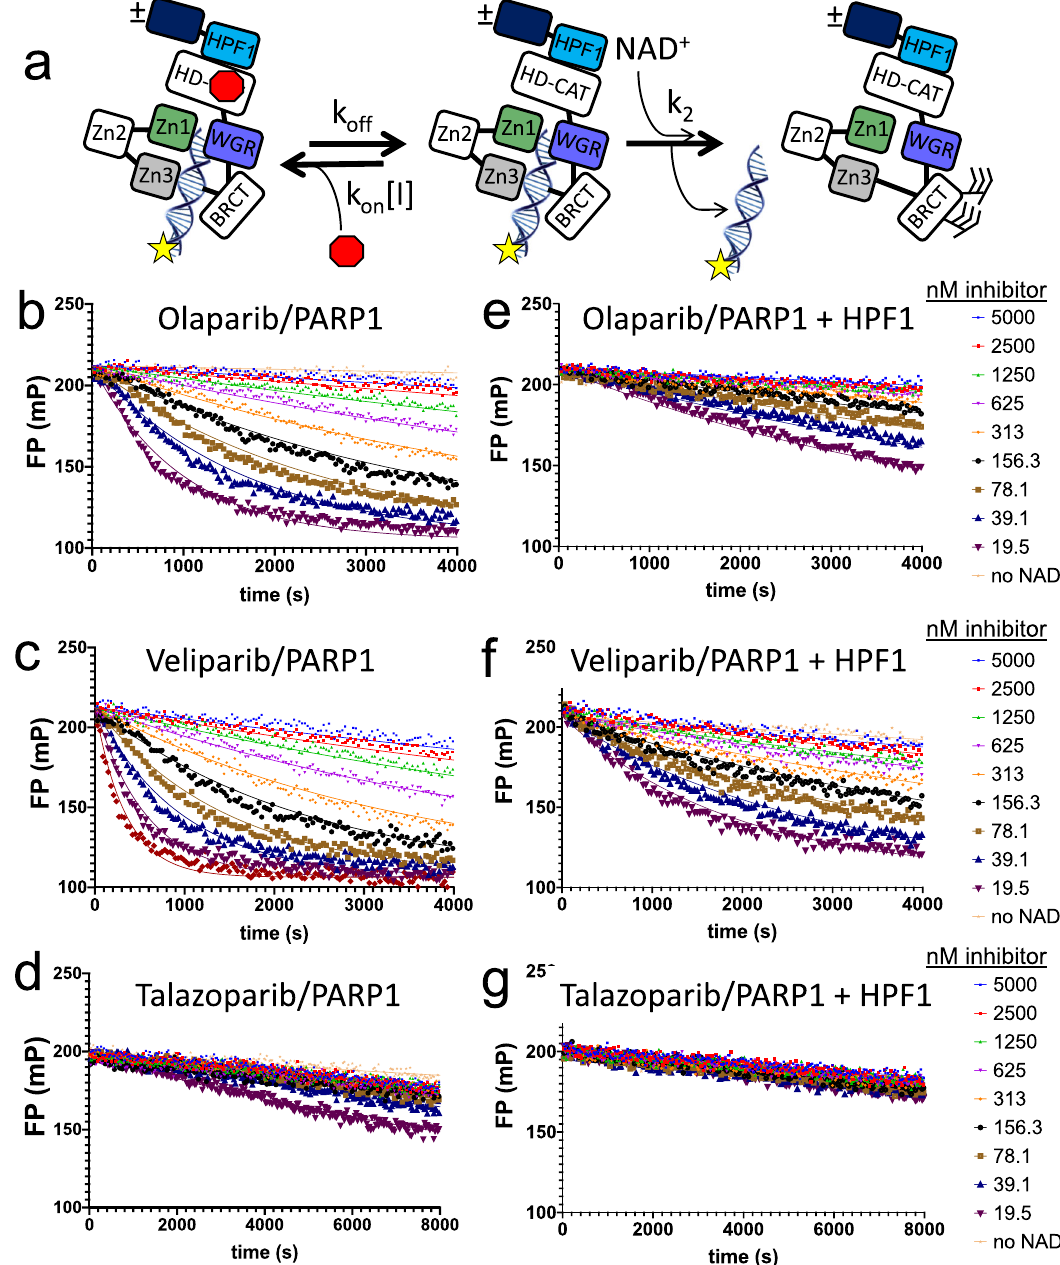
Fig. 1 Release of fl uorescently labeled DNA from PARP1 reveals binding af fi nity of PARPi for PARP1 and demonstrates that HPF1 slows the apparent release of PARPi from PARP1. a The domains of PARP1 involved in DNA binding (Zn1, Zn2, Zn3, WGR) and the catalytic domain with the HD motif that partially obscures the active site in the absence of DNA are shown as part of the assay scheme. The rates of association and dissociation of the inhibitor are k on and k off , respectively. The rate of PARylation of PARP1 is considered constant (k 2 [NAD + ]) and was determined independently (see Supplementary Fig. 4). b – d Representative p18mer*-release data for olaparib, veliparib and talazoparib with PARP1 alone. e – g Representative p18mer*-release data for olaparib, veliparib and talazoparib with PARP1 in the presence of HPF1. The concentrations of the inhibitors used in ( b – g ) are noted on the right in units of nanomolar. The lines through the shown data points re fl ect fi tting to fi rst-order kinetics (see